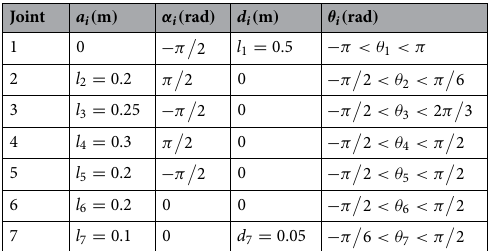
Table 1. DH parameters of the 7-DOF robotic manipulator 9